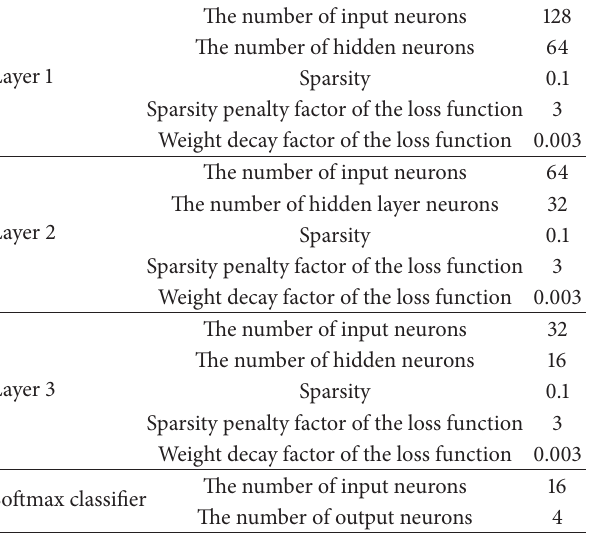
Table 8: Settings of SAE.